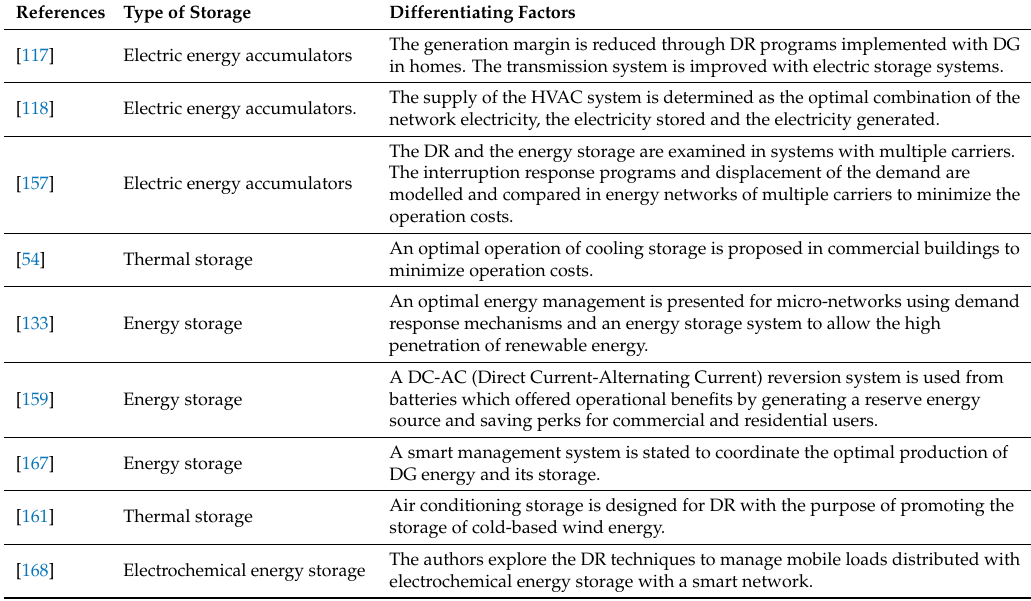
Table 9. DR programs and their connection with energy